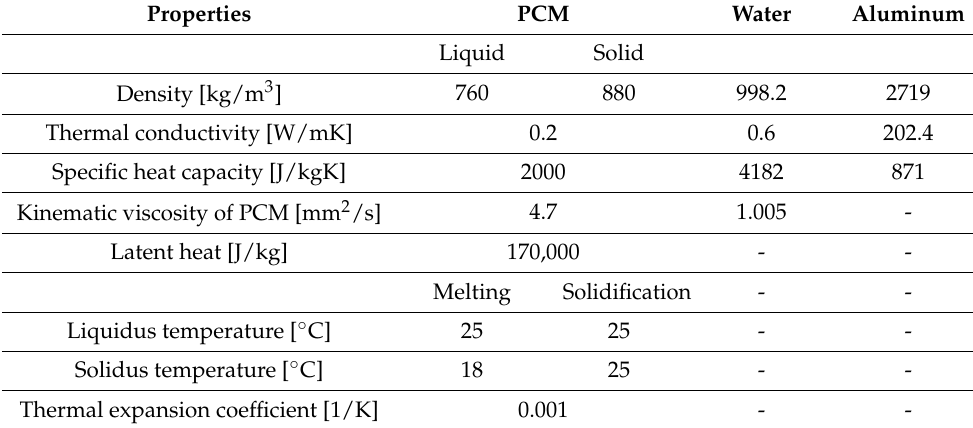
Table 2. Thermo-physical properties of PCM paraffin RT25, water and aluminum used in numerical simulations.